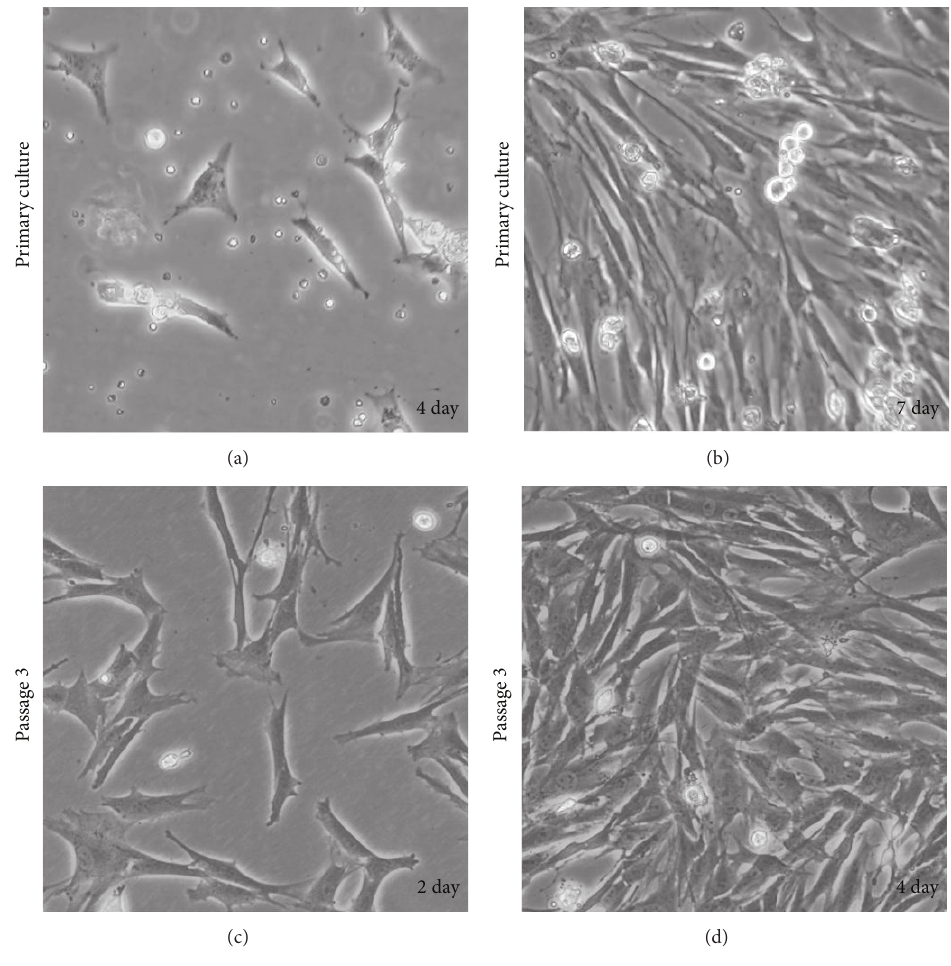
Figure 1: Representative fields of BMSCs